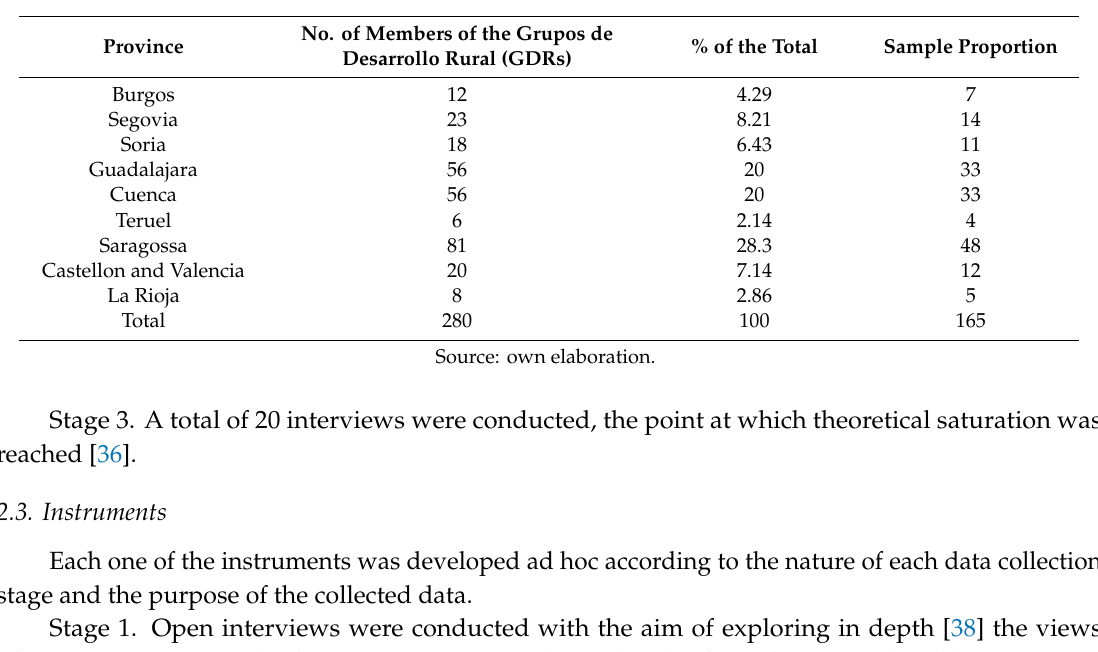
Table 1. Population and sample of the quantitative